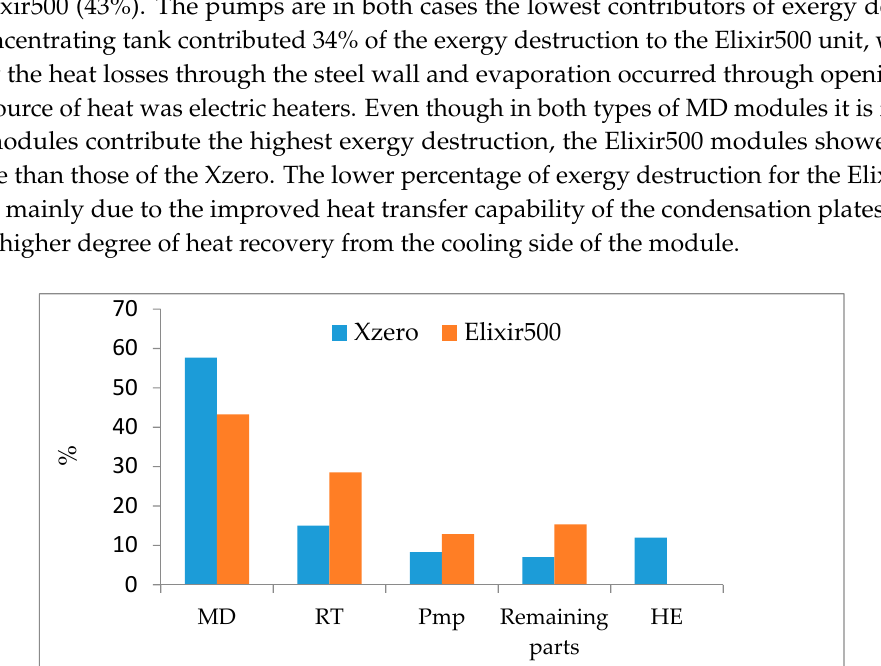
Table 2. Summary of exergy efficiencies for different MD configurations and RO from the literature.